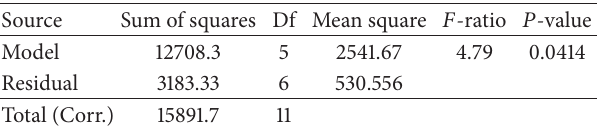
Table 4: ANOVA test.